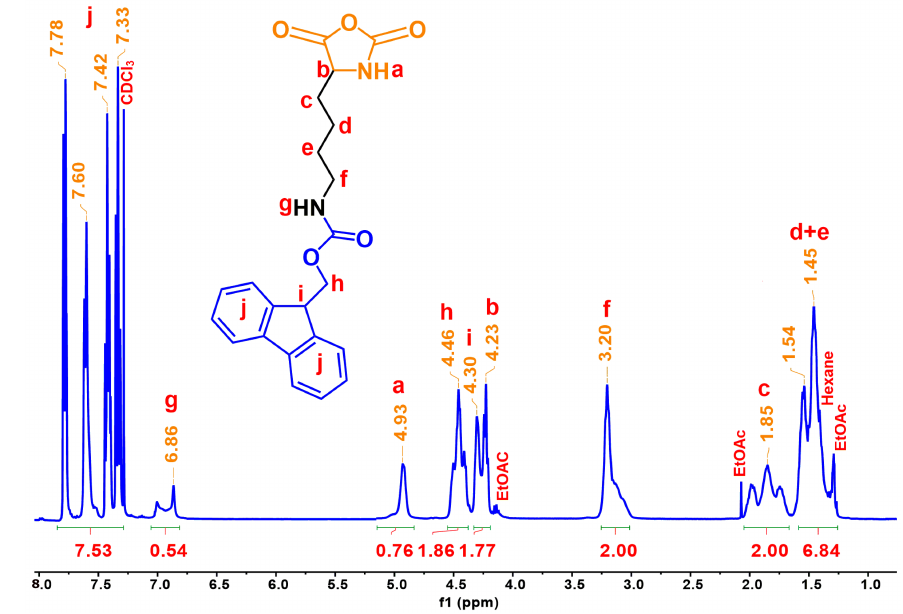
Figure 3. 1 H-NMR spectrum of N ε -Fmoc- l -Lysine NCA in CDCl 3 .